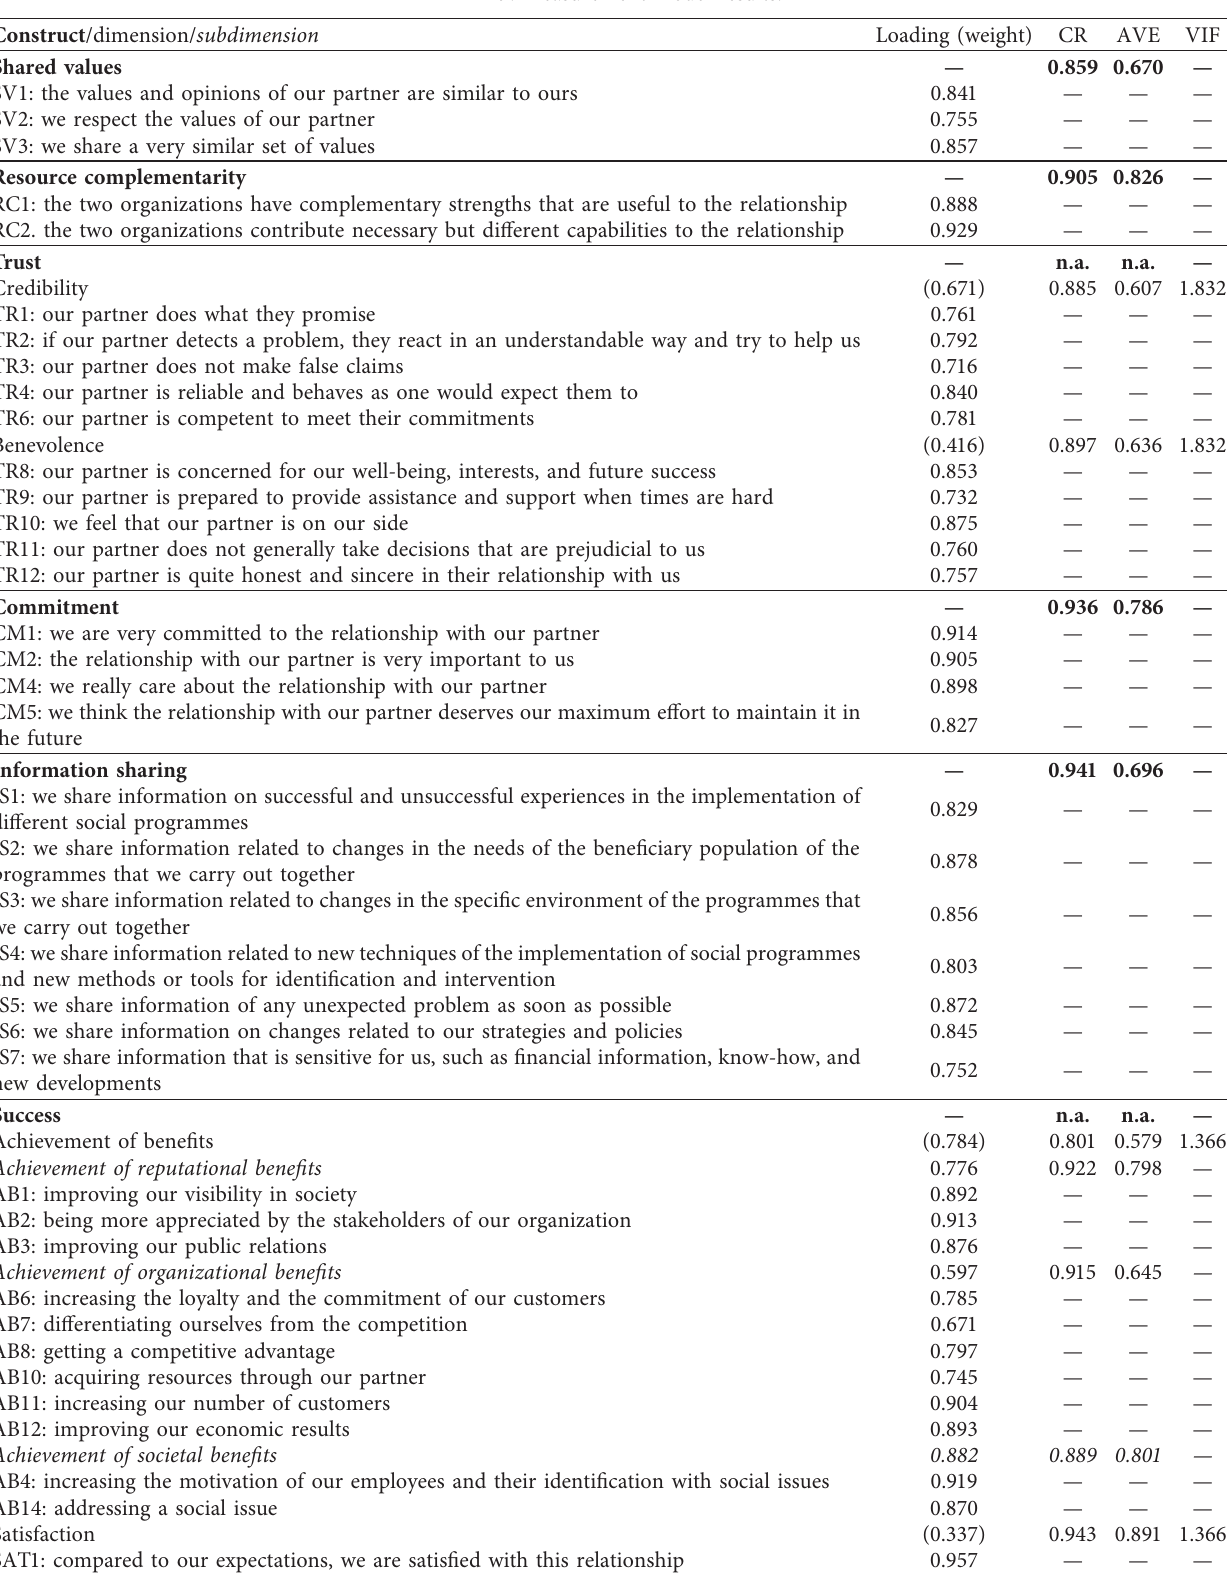
Table 9: Measurement model